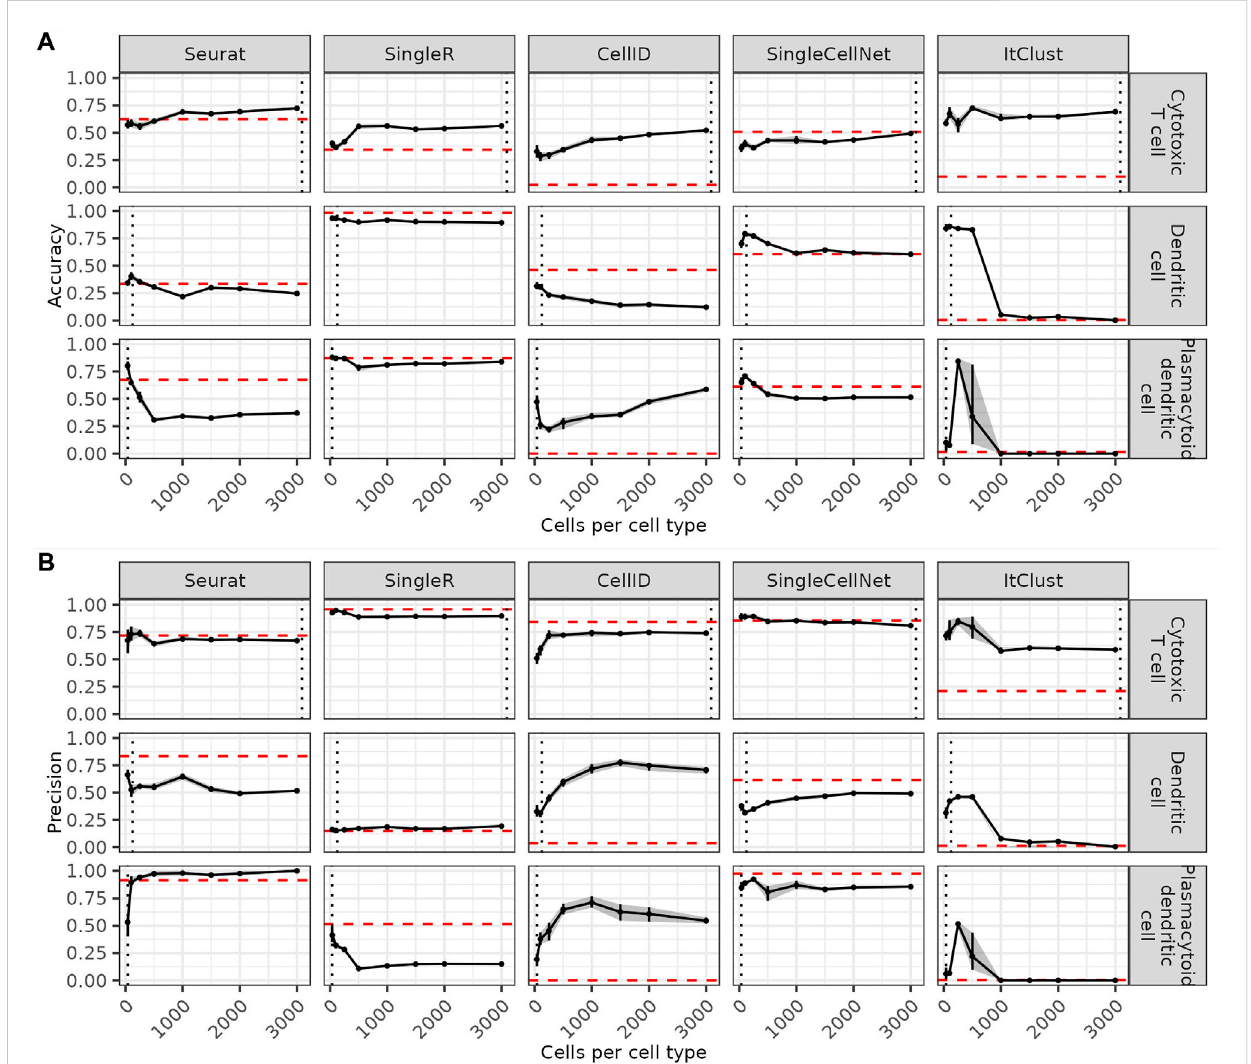
FIGURE 2 Effect of the number of cells per cell type on the predictions. Accuracy (A) and precision (B) for three example cell types in each method, when the number of cells per cell type is increased. The red dashed line shows the accuracy on the full data and the grey dashed line shows the number of cells in this cell type in the full reference data. Con fi dence intervals for 20 bootstraps are shown by a grey